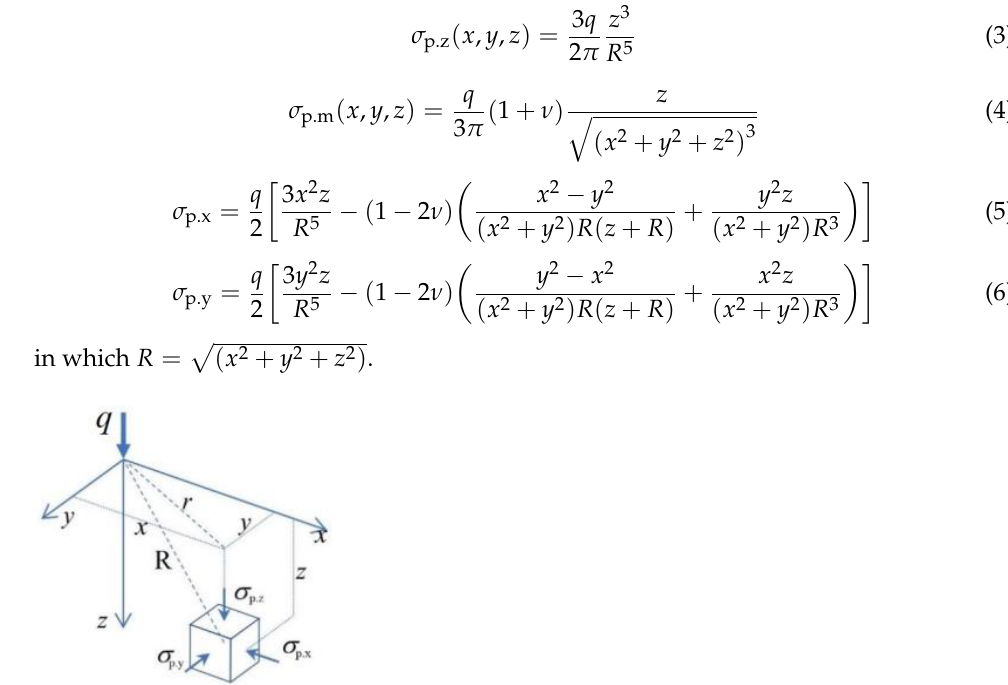
Figure 2. Stress in an elastic half-space caused by a vertical point load on the surface.